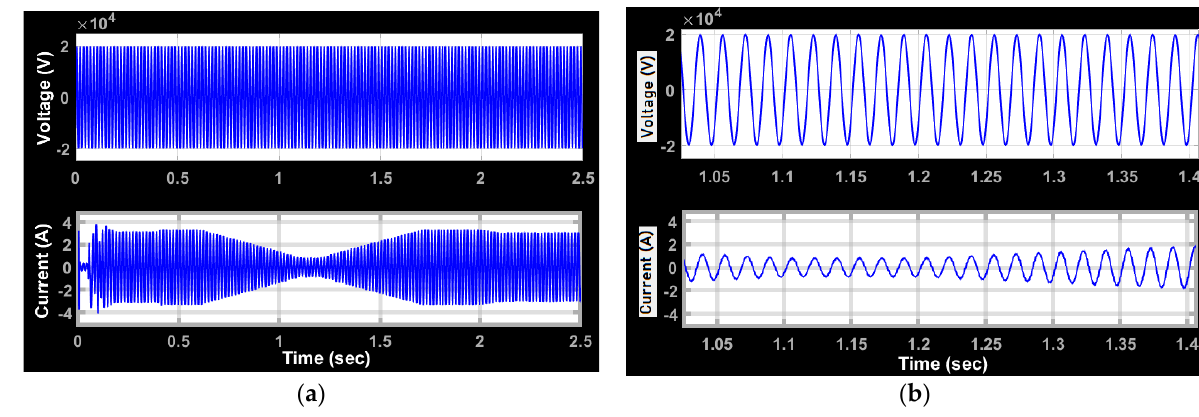
Figure 11. ( a ) Grid parameters of voltage and current. ( b ) Zoom view of grid.